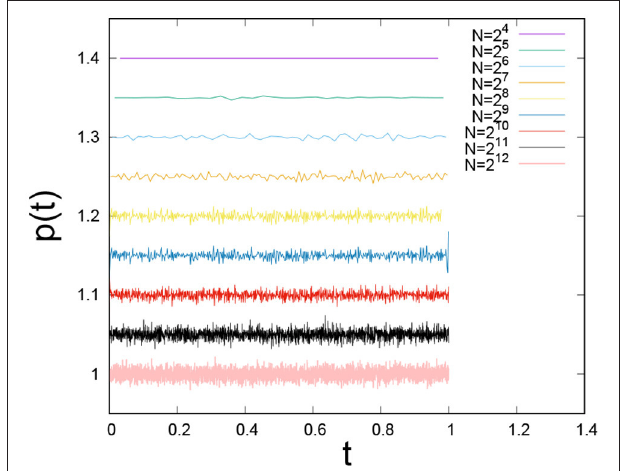
FIGURE 1 | Evolution of threshold distribution for M 10 6 fiber bundles, each = containing N 2 12 fibers when repeating the order space renormalization = group transformation. The initial threshold distribution was uniform on the unit interval. We have added a constant factor to p ( t ) for each iteration of the renormalization group in order to separate